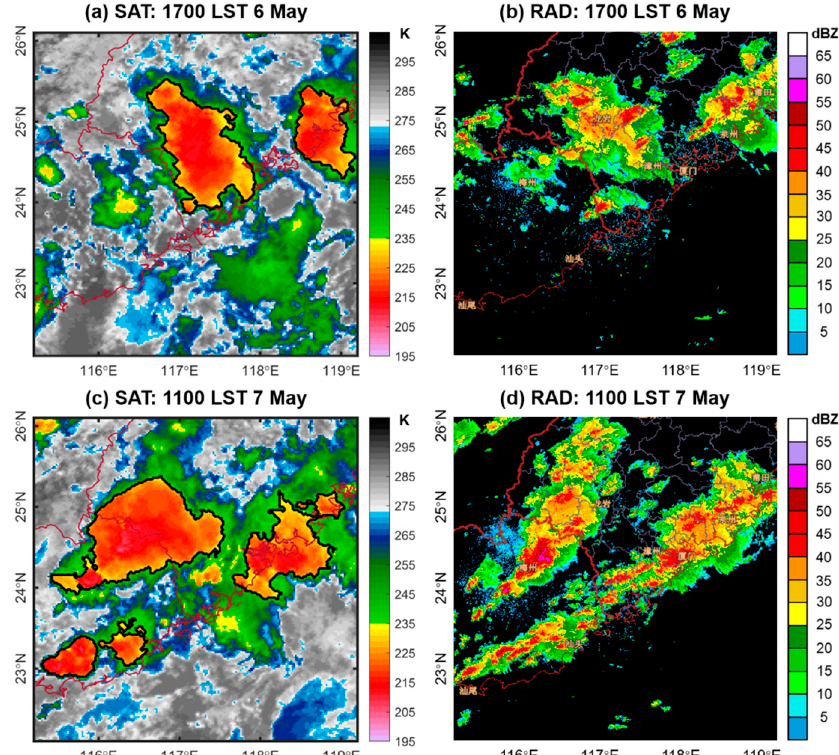
Figure 3. Infrared cloud image from Himawari-8 satellite and its corresponding radar mosaic of composite reflectivity (i.e., maximum reflectivity in a vertical column) at ( a , b ) 1700 LST (LST = UTC + 8 h) 6 May 2018 and ( c , d ) 1100 LST 7 May 2018, showing some identified MCS samples (areas enclosed by black solid lines). The provincial boundaries are denoted by red curves.